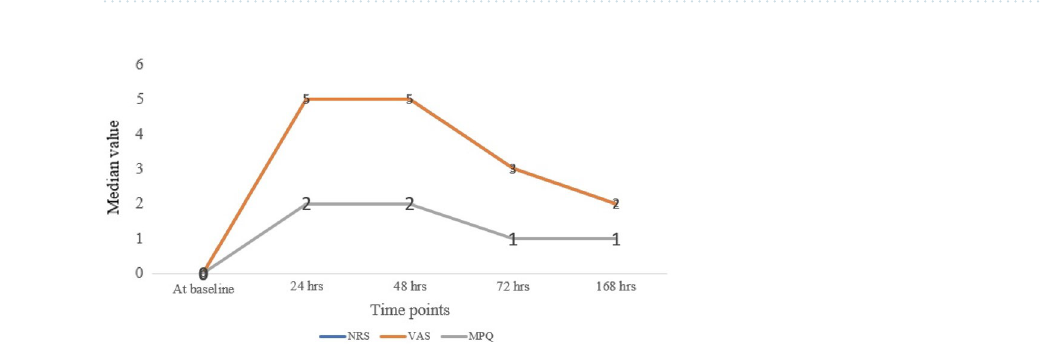
Figure 2. Median of Numerical Rating Scale (NRS), Visual Analogue Scale (VAS), and McGill Pain Questionnaire (MPQ) over time points.